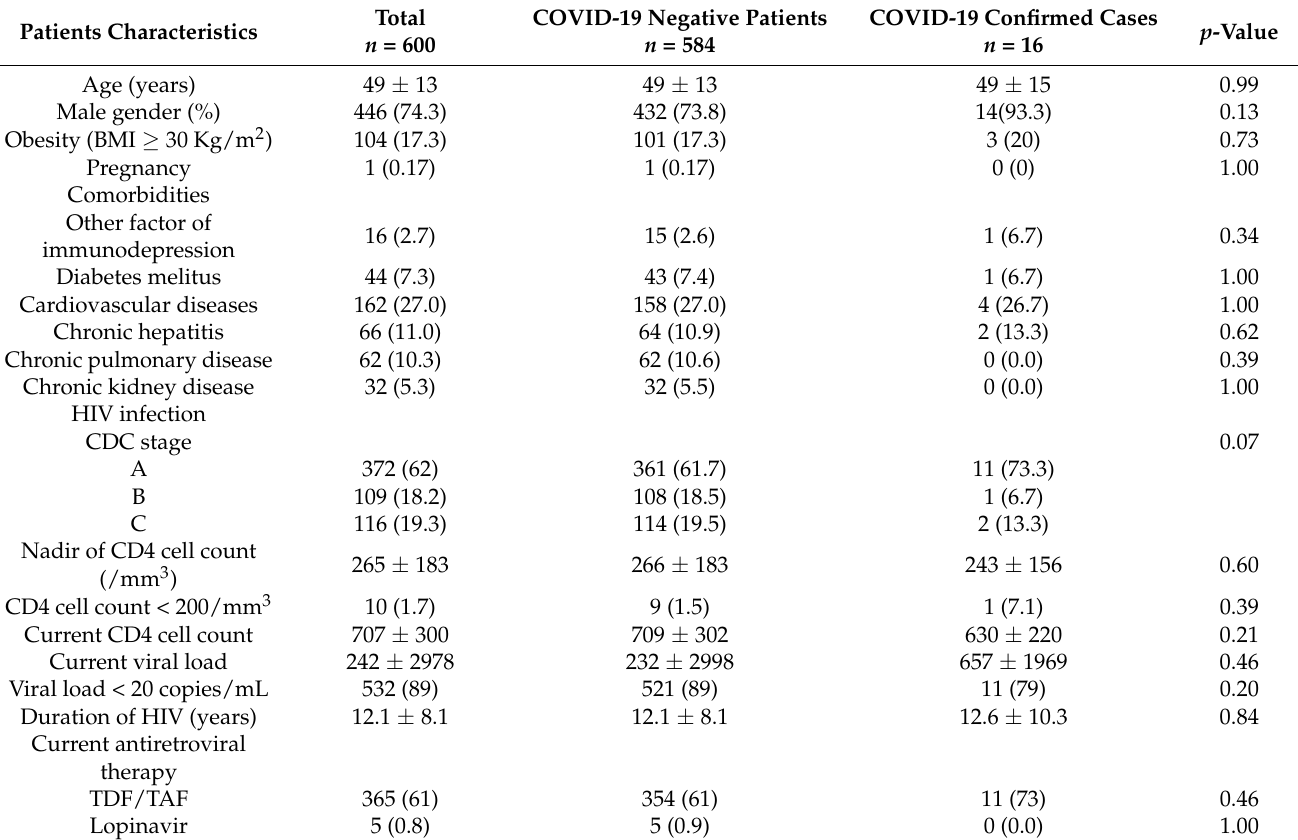
Table 1. Demographic and clinical characteristics of our patients, depending on the COVID-19 status. Patients